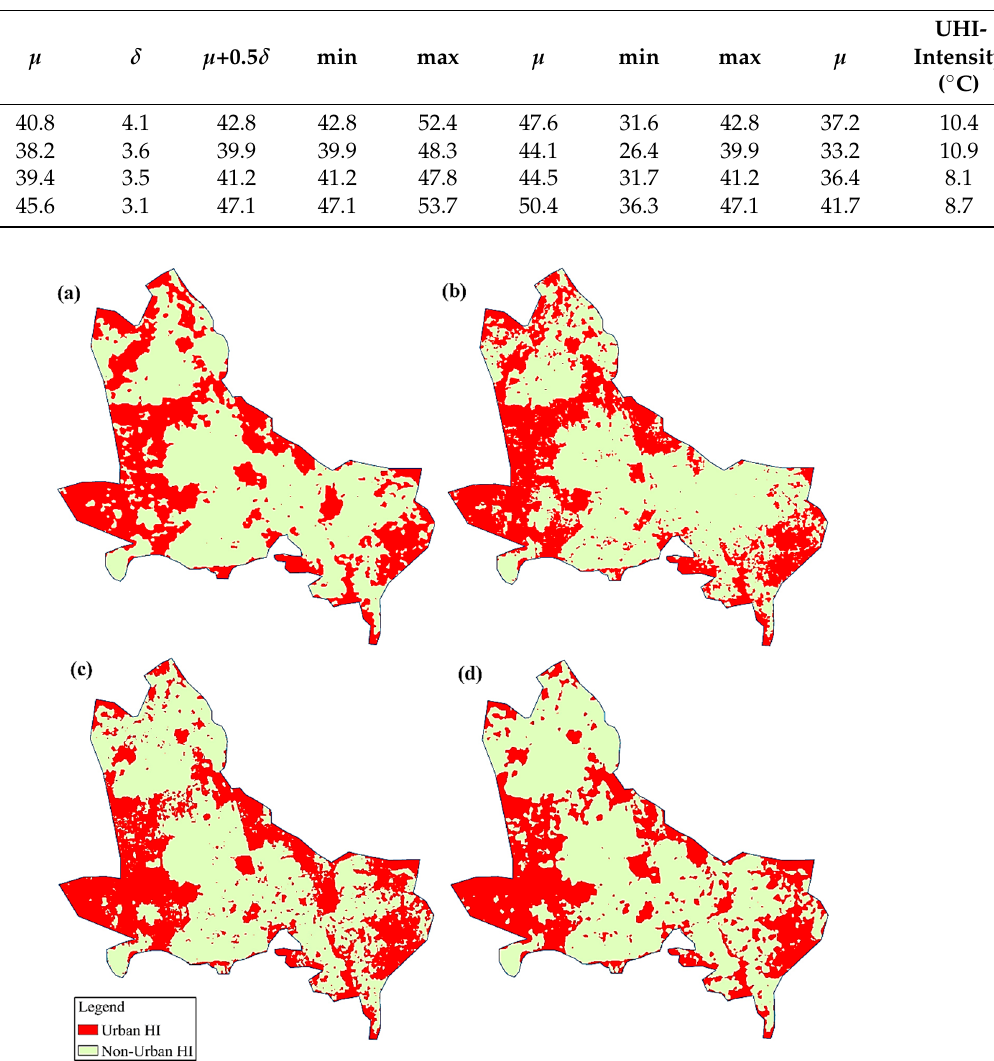
Figure 5. The extracted UHIs over the study area for the periods ( a ) 1990, ( b ) 2000, ( c ) 2010, and ( d )